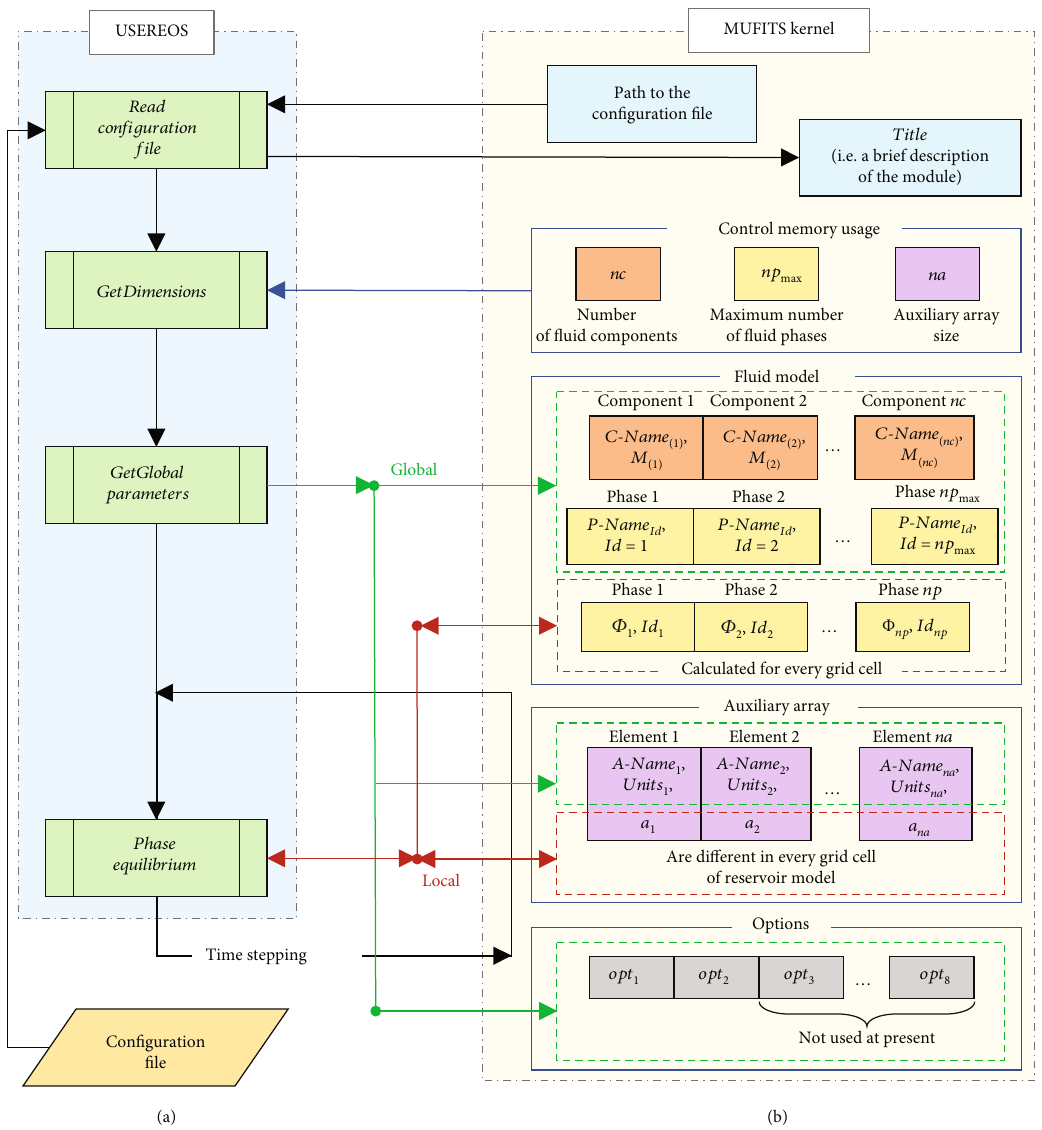
Figure 2: Sketch of data fl ows associated with USEREOS. The green and red dashed boxes in the right panel show the global and local parameters,